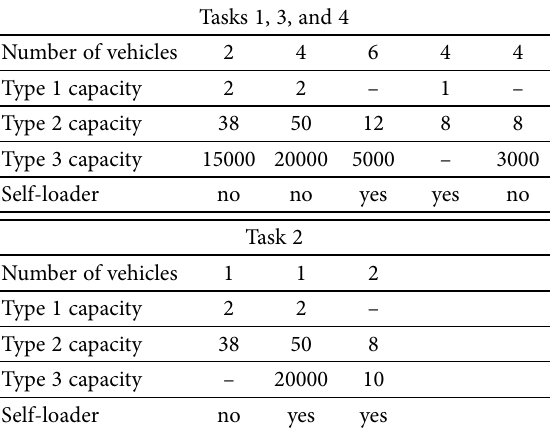
Table 3. Vehicle capacities for different cargo types Tasks 1, 3, and 4